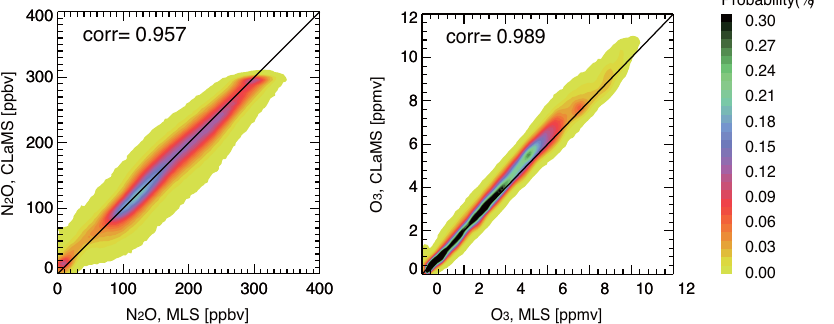
Figure 3. PDFs (probability distribution functions) of MLS observations and CLaMS reference simulation for the entire simulation period from 1 December 2008 to 1 April 2009 for APs in the Northern Hemisphere with 400K < θ < 1000K (left: N 2 O, right: O 3 ).